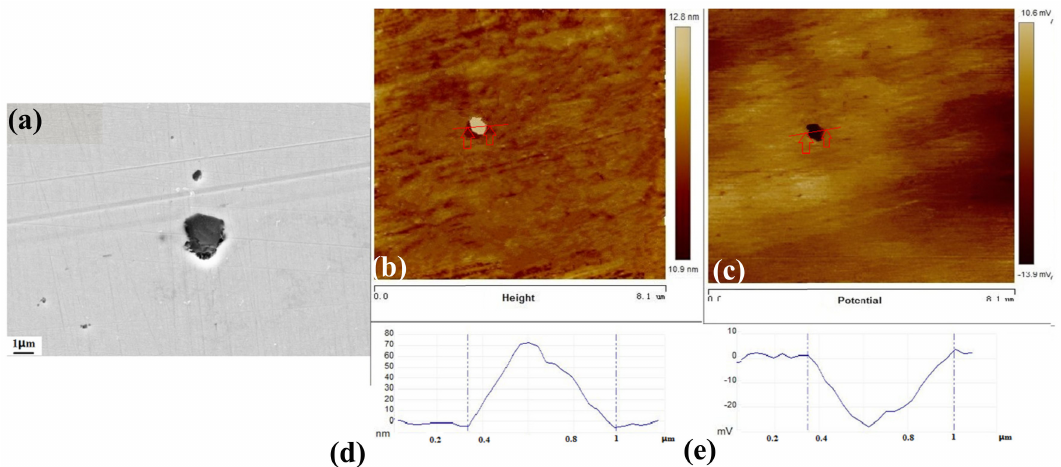
Figure 10. SEM and SKPFM images around the type C inclusion: ( a ) SEM image; ( b ) AFM topography image; ( c ) Surface potential distribution of the same area; ( d ) Topography section analysis; ( e ) Section analysis of the surface potential.